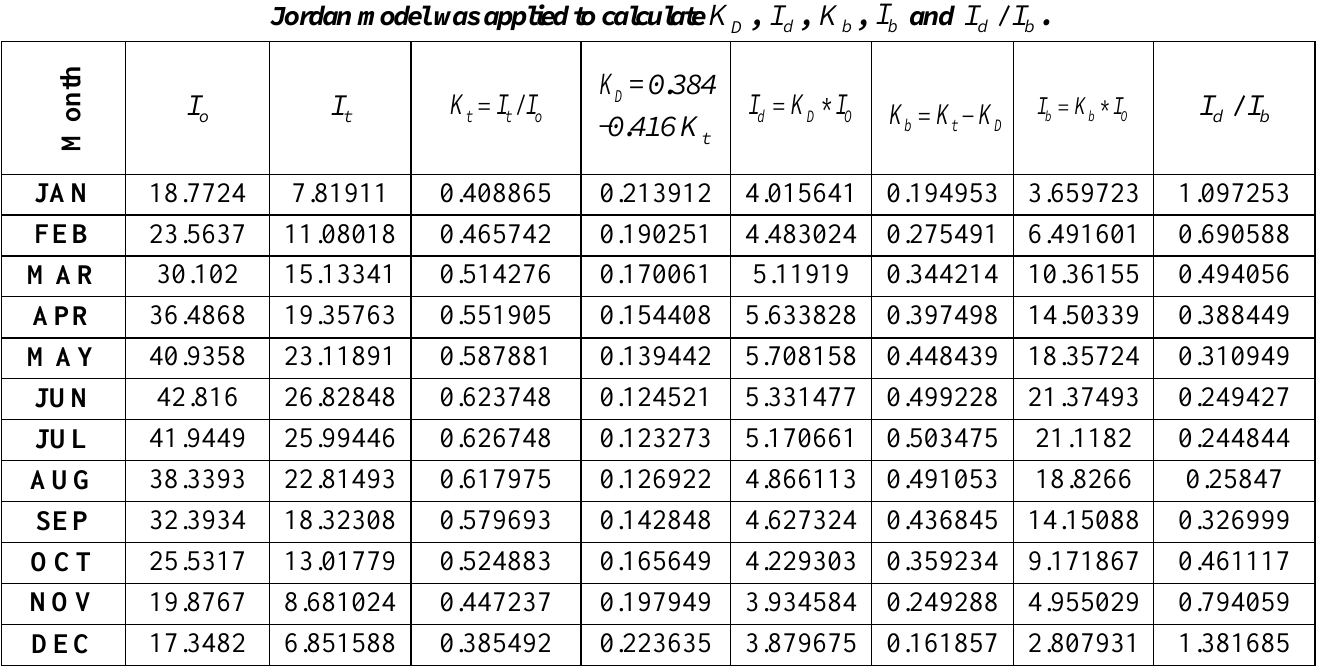
Table 2: Clearance index was applied in equation (5) for Baghdad city at a period (1983-2005) and Jordan model was applied to calculate